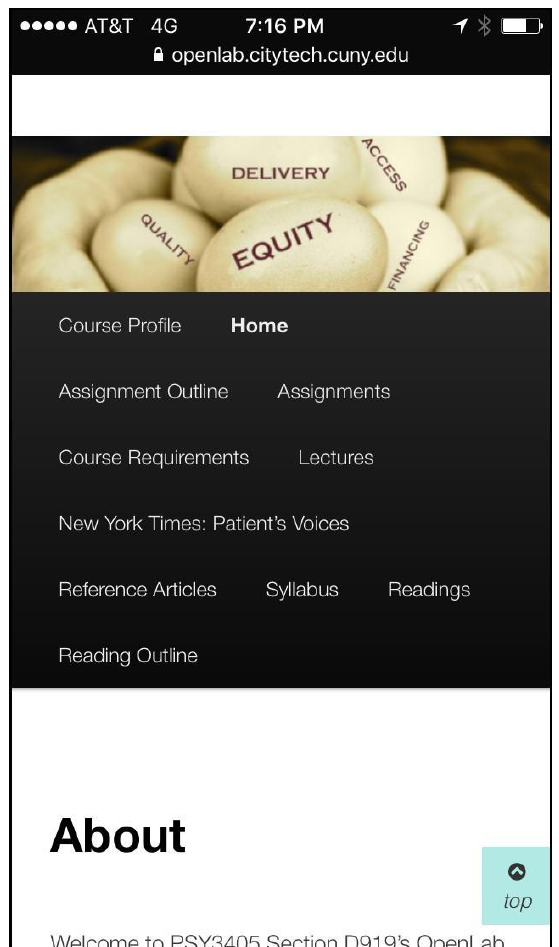
Figure 4. Detail of the mobile version